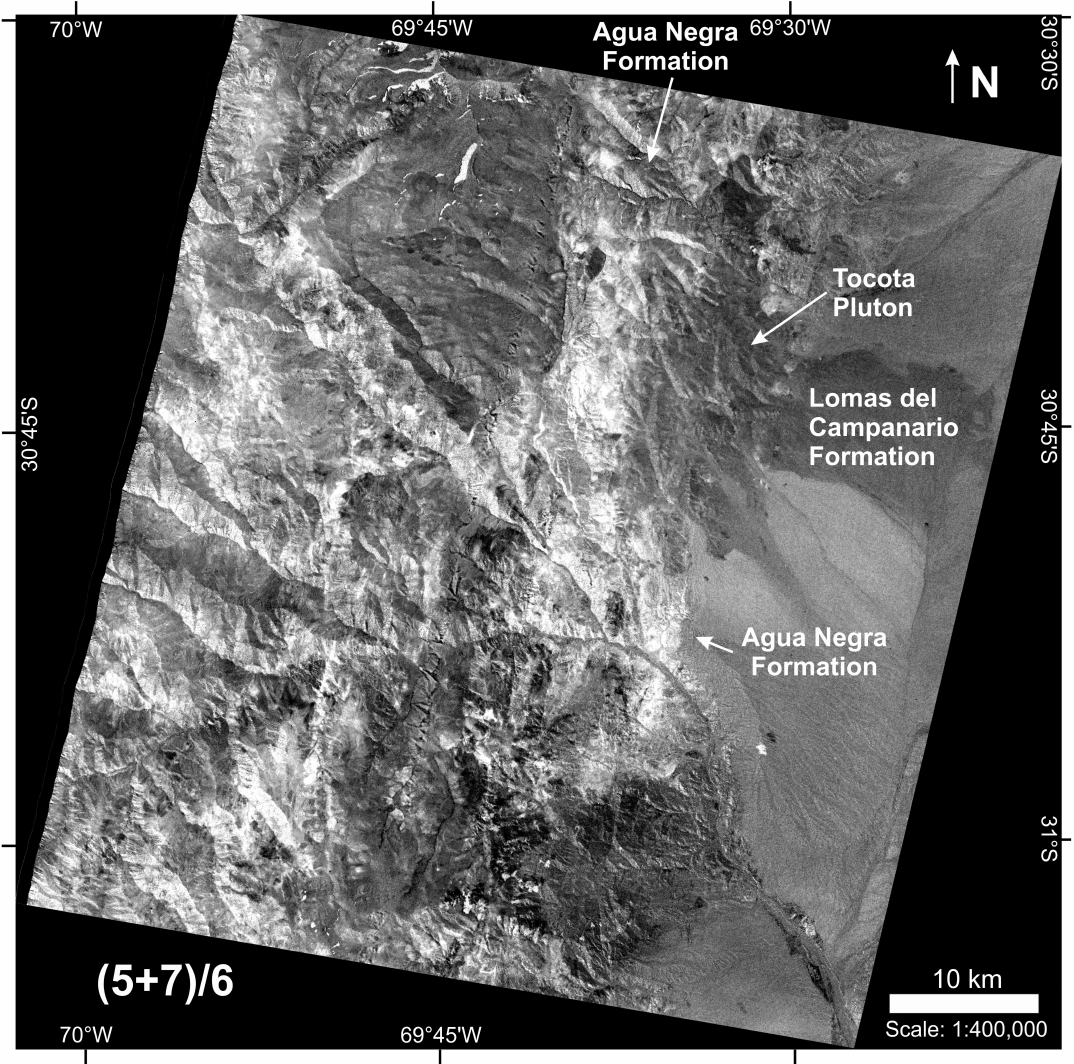
Figure A4. Grey-scale image with the ASTER band operation (5 + 7)/6. The product of this operation differentiates the sedimentary rocks of Agua Negra Formation from the darker Tocota Pluton and El Palque Formation. The Loma del Campanario Formation exhibits darker colors than the alluvial